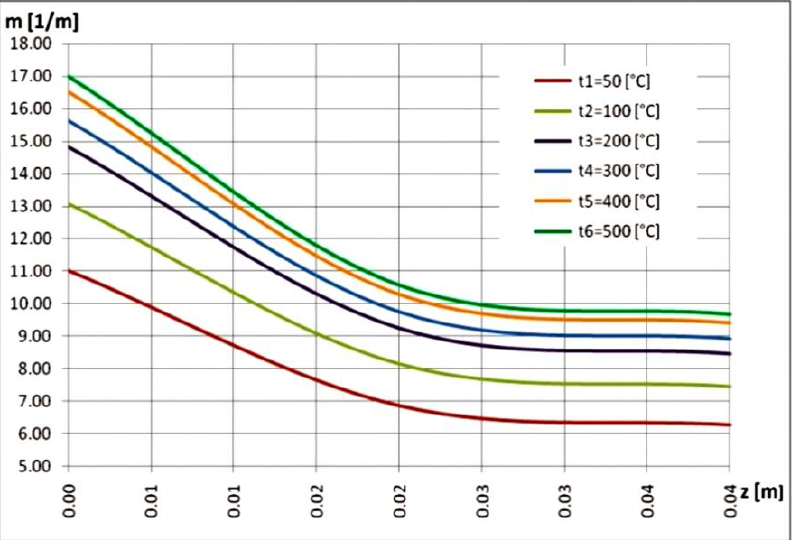
Figure 20. The variation in the parameter “ m ” along the first significant interval of the bar ( (cid:96) (cid:48) I = z = [ 0.000 − 0.040 ] m ) , for α g = 90 ◦